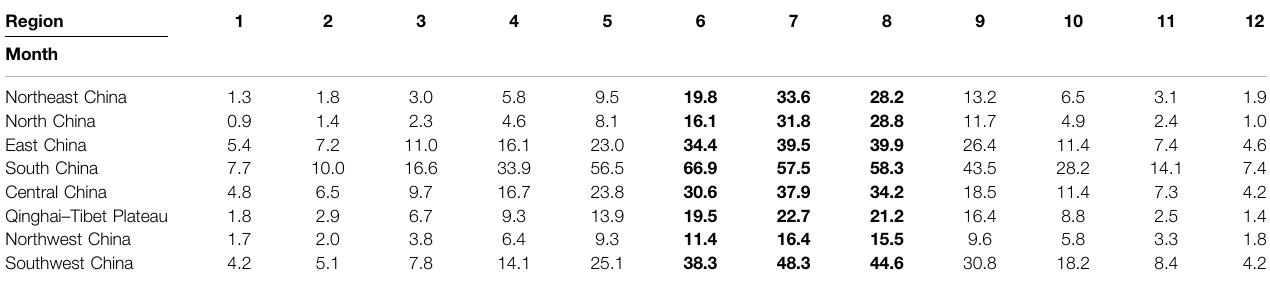
TABLE 6 | MAE for the cross-validation of precipitation (unit: mm). Region